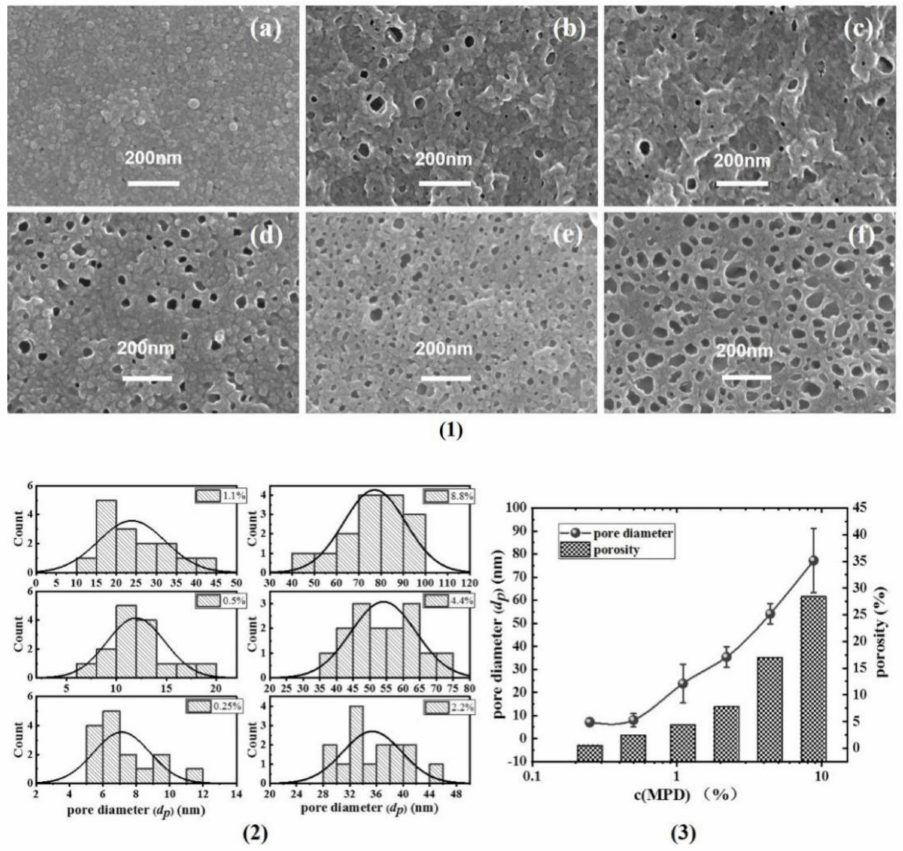
Figure 2. ( 1 ) SEM images of PA’s back surface, ( a – f ): TFC − 1~TFC − 6; ( 2 ) the statistics of the pore diameter ( d p ); ( 3 ) the summarizing of the pore diameter and porosity ( ϕ o ). Figure 3 showed the TEM cross-sectional micro-images of TFC − 1 to TFC − 6. Based on these micro-images, δ int and δ app are derived (deriving protocols shown in SI). For lower c (MPD) TFC − 1 and TFC − 2, the TEM micro-images had a much lower contrast compared to TFC − 6 with high c (MPD). Such a phenomenon might suggest a lower PA layer density (e.g., cross-linking degree) at low c (MPD) (and hence electron penetration will be higher). All in all, that experimental phenomenon demonstrates that the lower c (MPD)-reacting monomer produces the thinner δ int . While varying c (MPD) from 0.25% to 8.8%, the δ int increased significantly from 5.65 ± 0.76 nm to 29.75 ± 1.96 nm. In comparison, the δ app increased from 36.71 ± 14.27 (TFC − 1) to 118.29 ± 26.12 (TFC − 4), and then gradually decreased to 81.08 ± 16.91 (TFC − 6). The δ int monotonically increases with the increment of c